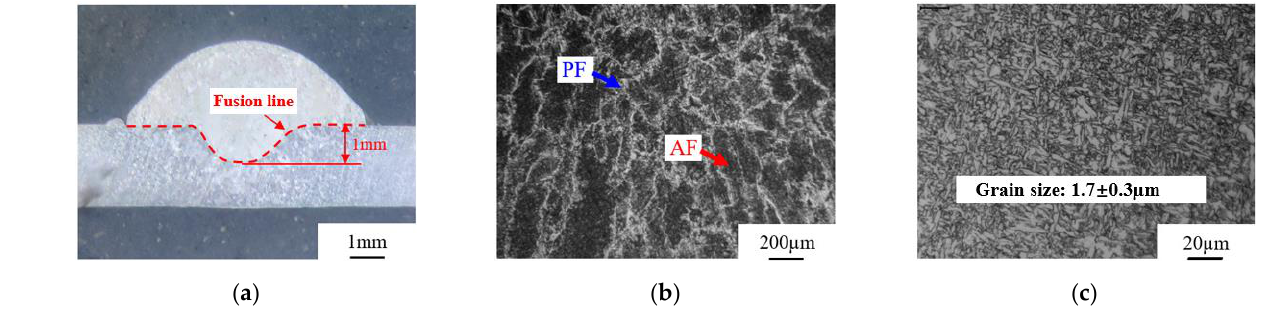
Figure 22. Morphology and structure of weld ( I = 60 A, I p = 525 A): ( a ) macroscopic morphology of weld; ( b ) microstructure at the center of the weld; ( c ) high magnification image of the AF phase.